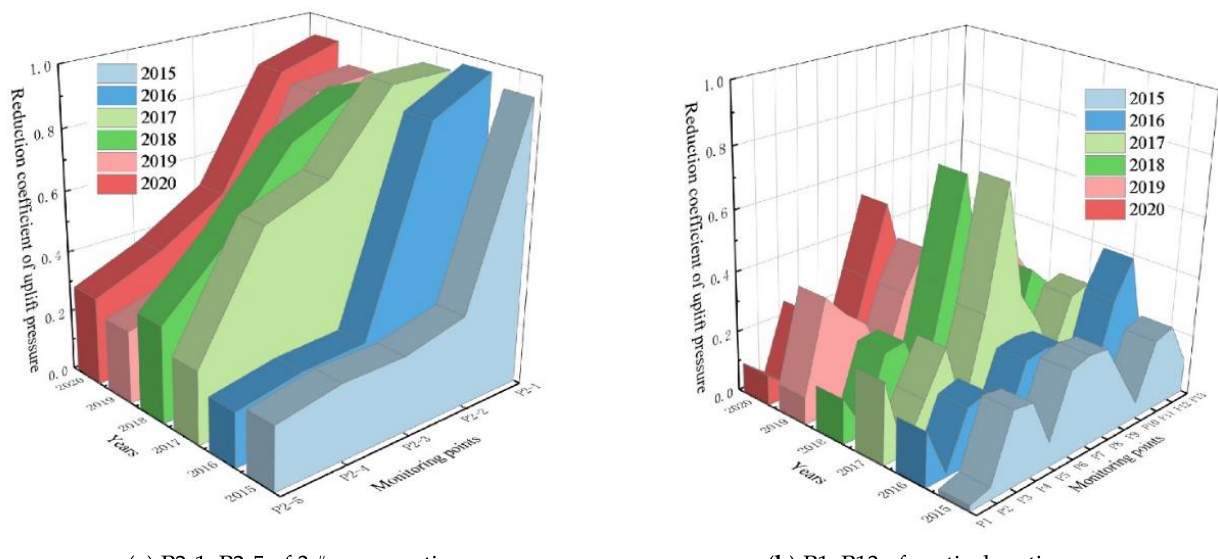
Figure 8. Variation of annual maximum reduction coefficient of uplift pressure monitoring points. To further verify the accuracy of the anomaly identification result of the DBSCAN, SIR-4000 geological radar and 100 MHz shielding detection antenna are used for non-destructive testing. Non-destructive testing of the dam foundation in the middle of the riverbed is carried out in the corridor at the bottom of the dam body, and the testing result is shown in Figure 9. At a depth of 7 – 15m near the P2-4 monitoring point, the overall continuity of the foundation is relatively poor, and the in-phase axis dislocation is intense. There are apparent small-scale wave groups, and the local reflection wave appears as an arc. The high frequency has a specific loss, and the low frequency is locally prominent. It is speculated that the geological body here is not dense, and there may be cracks. Therefore, the non-destructive testing results further verify the possibility of seepage failure in the riverbed and the accuracy of anomaly identification model based on the DBSCAN.